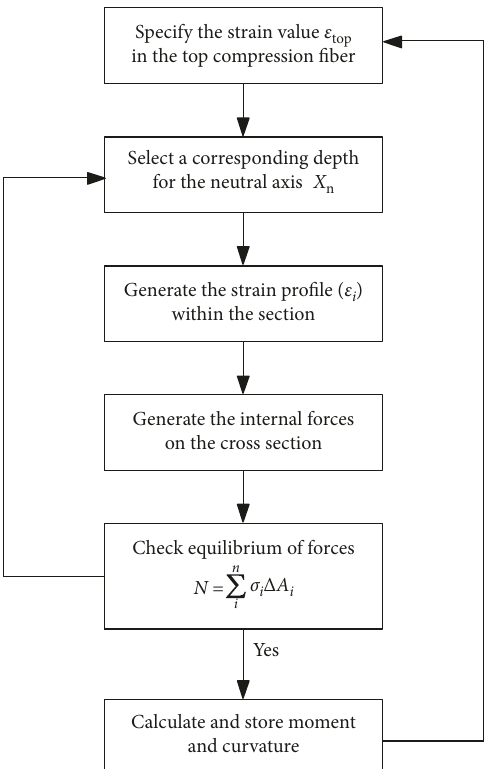
Figure 2: Flow chart of the numerical procedure for section analysis.